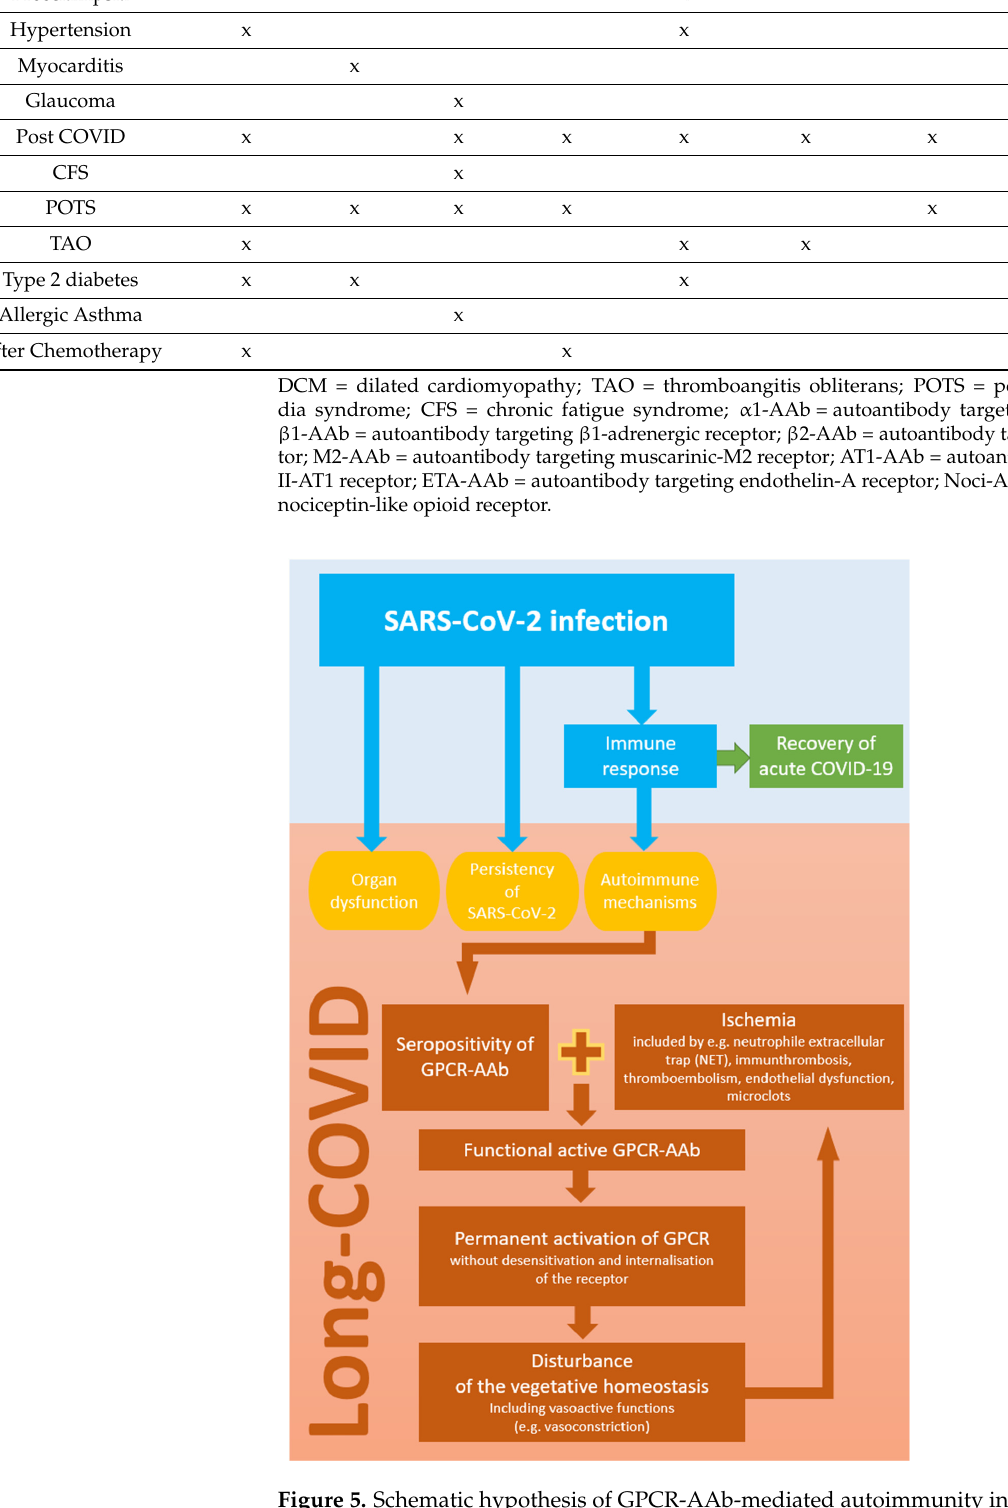
Table 4. Seropositivity of GPCR-AAbs in local and systemic disorders. α 1-AAb β 1-AAb β 2-AAb M2-AAb AT1-AAb ETA-AAb Noci-AAb MAS-AAb